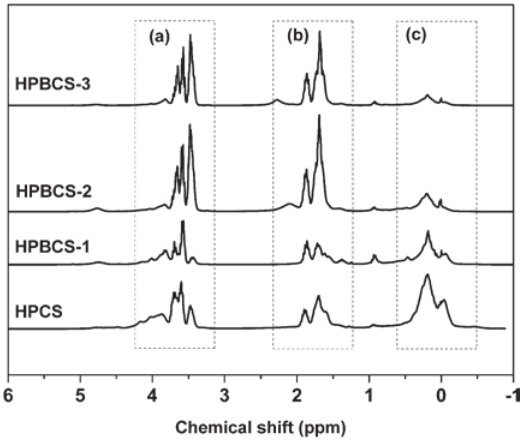
Fig. 3: 1 H NMR spectra of HPCS and HPBCS. Fig. 4: 29 Si NMR spectrum of